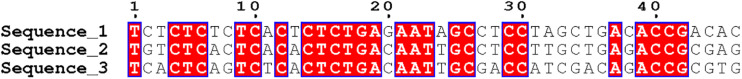
DNA sequence fragment alignment diagram.